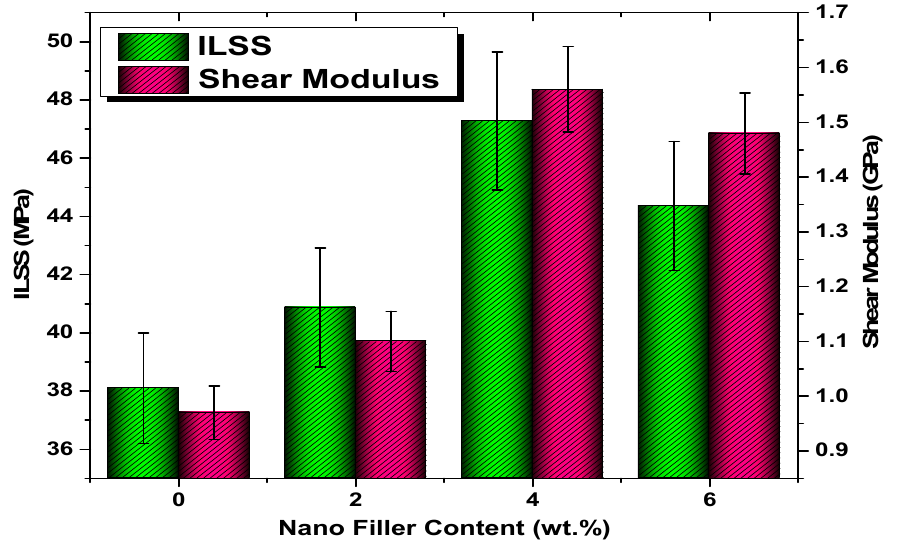
Figure 5. The ILSS and shear modulus of flax/OPS nanofiller/epoxy-based hybrid composites under room temperature.